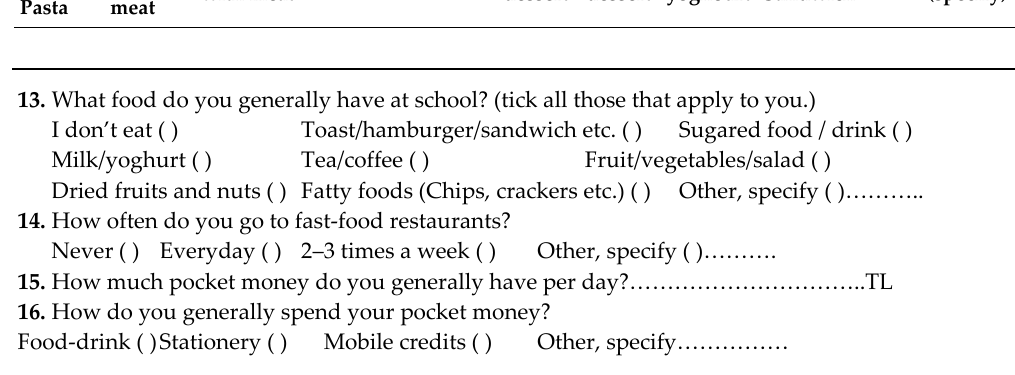
Figure A2. Survey Form Used in Research (English translated version).